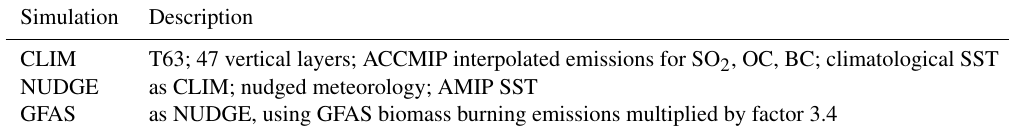
Table 2. Setup of the simulations with